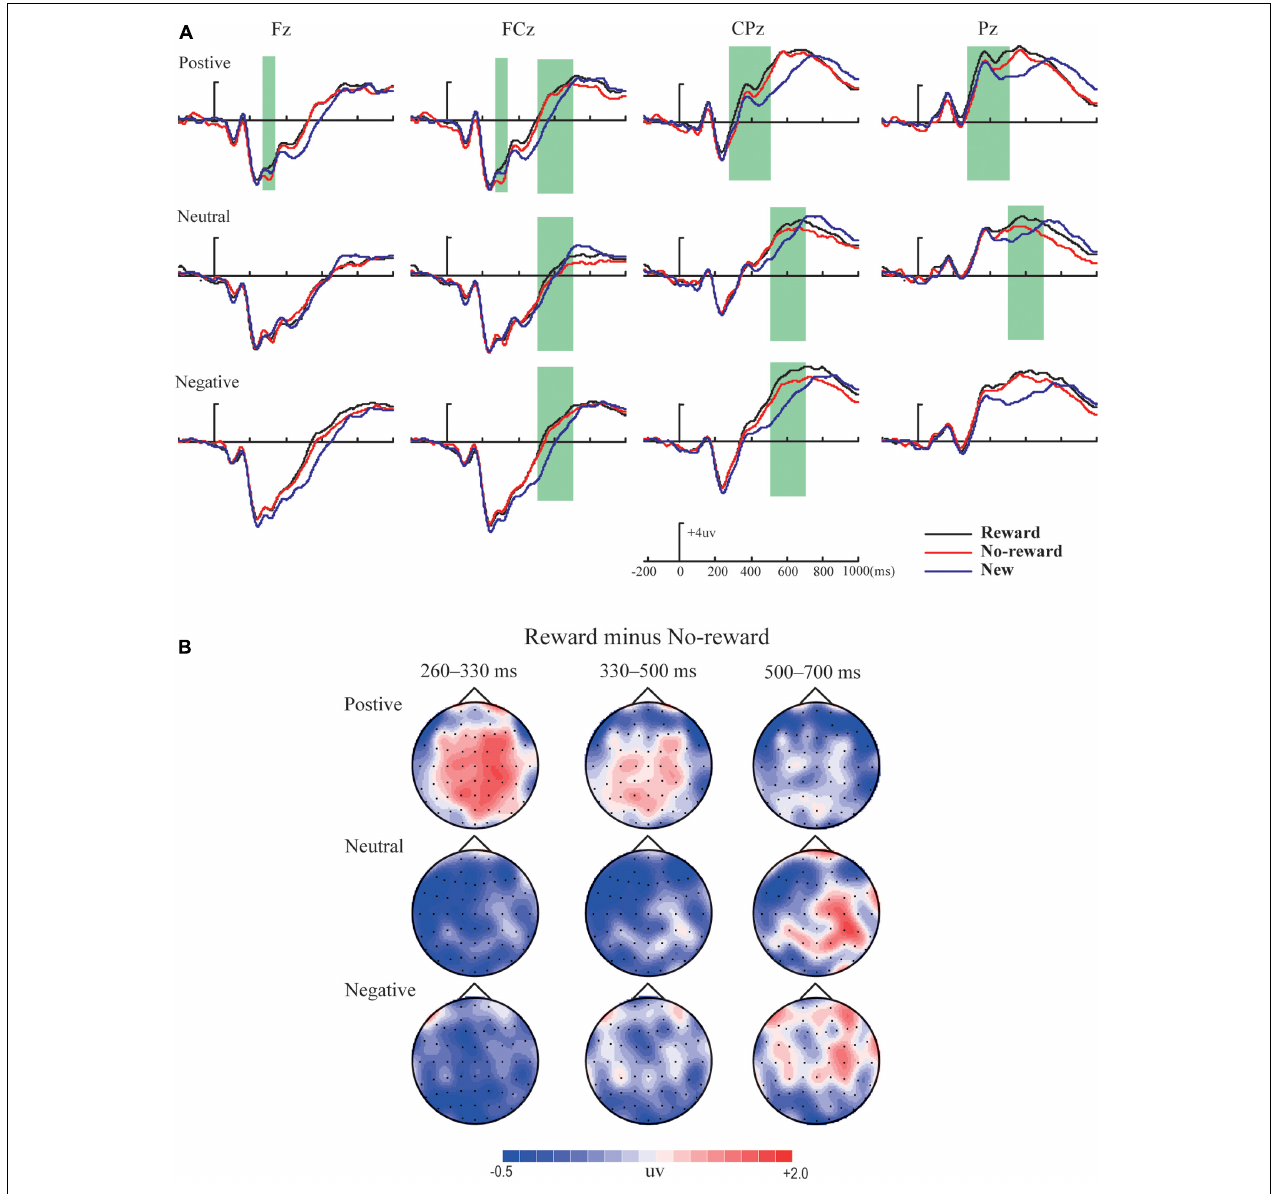
FIGURE 2 | The amplitude distribution and topographic map of ERP about reward effects in positive, neutral and negative emotion conditions. (A) The amplitude comparison of old items with reward, old items without reward and new items under three emotional conditions. (B) The topographic map of ERP about reward effects (reward minus no-reward) under three emotional